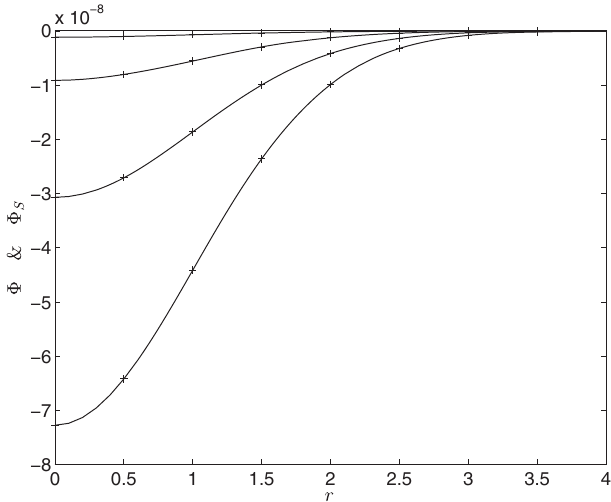
FIG. 7. Plot of the exact infinite medium solutions versus the bounded medium series solutions under Dirichlet boundary conditions. The infinite medium solutions, in solid, are using the parameters shown in Table I. The truncated series solutions ∼ 10 − 4 . The are in cross points, with m ¼ 200 yielding an ϵ rms four distinct curves shown in descending order are for t ¼ 0 . 25